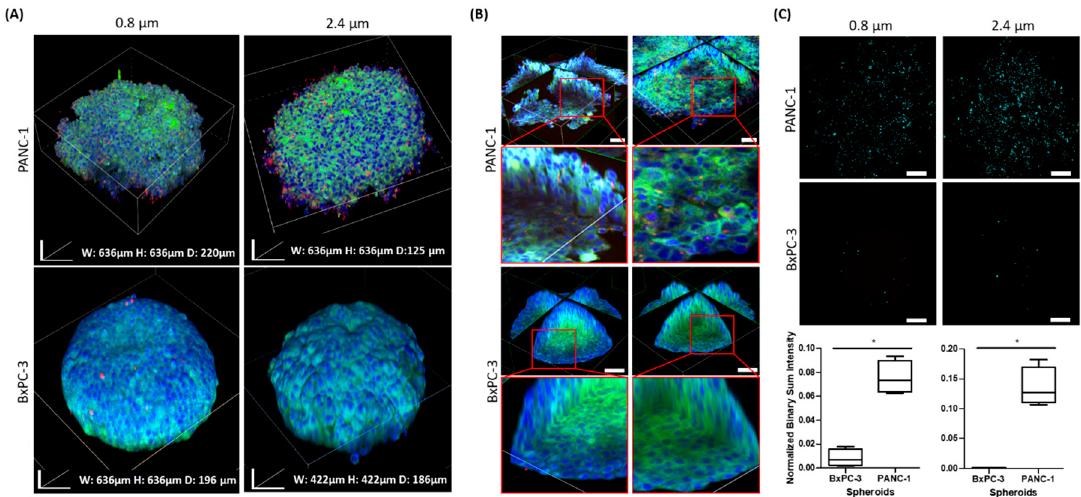
Figure 6. Particle penetration and biodistribution studies in BxPC-3 and PANC-1 spheroids as an ex vivo tumor model. BxPC-3 and PANC-1 spheroids were incubated with either 0.8 or 2.4 µ m size fluorescent purple microparticles (red) over a period of 24 h. The spheroids were fixed, permeabilized, stained with DAPI (blue) and Coumarin-6 (green), and cleared. ( A ) Z-stacking images of BxPC-1 and PANC-1 spheroids were reconstructed into 3D images showing surface interaction with particles. ( B ) Optic cross-sections of the spheroids show interactions with particles in the deep cell layers. Scale bar = 50 µ m. ( C ) Representative stack-projection images of 0.8 and 2.4 µ m particles detected in BxPC-3 and PANC-1 spheroids after 24 h of incubation. The red color was converted to light blue to increase color contrast so as to enhance optical visualization. Graphs show quantification of the particles’ total projected fluorescent signals measured by NIS Elements AR Analysis software, n = 4, * p < 0.03. Scale bar = 100 µ m.